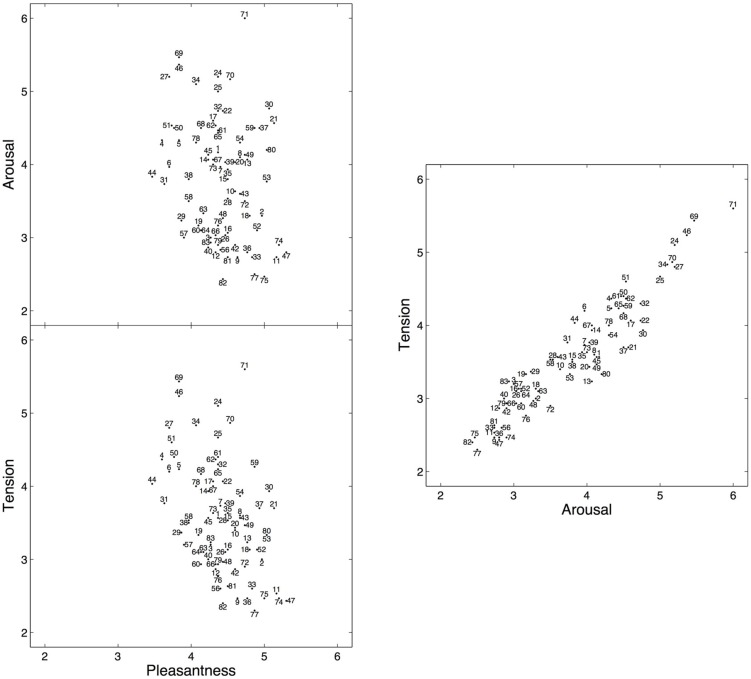
Mean subjective arousal, tension, and pleasantness ratings for 80 six-second excerpts selected from Romantic piano trios. The numbers identify the excerpts (for a complete listing of the excerpts, see Appendix in the Supplementary Material). The full scale for all three ratings ranged from 1 to 7, but a restricted range is displayed here to facilitate viewing.